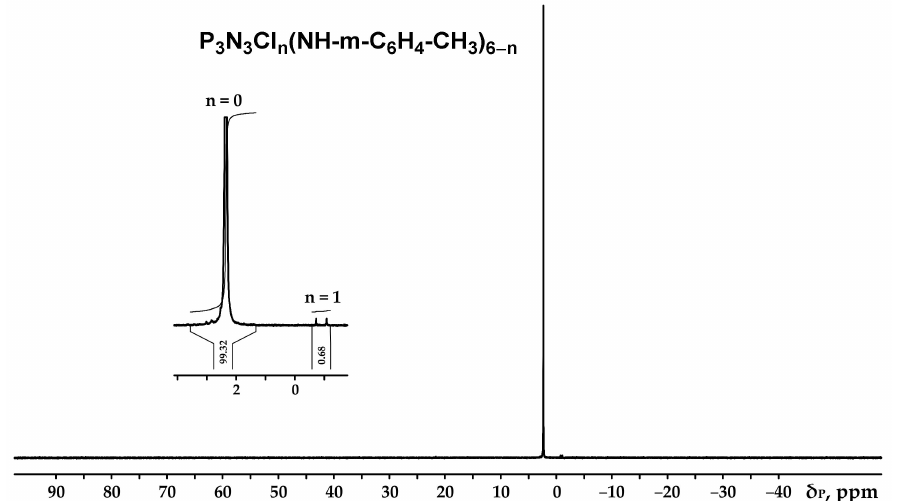
Figure 2. NMR 31 P spectrum of hexa-(m-toluidine)cyclotriphosphazene (PN-mt).